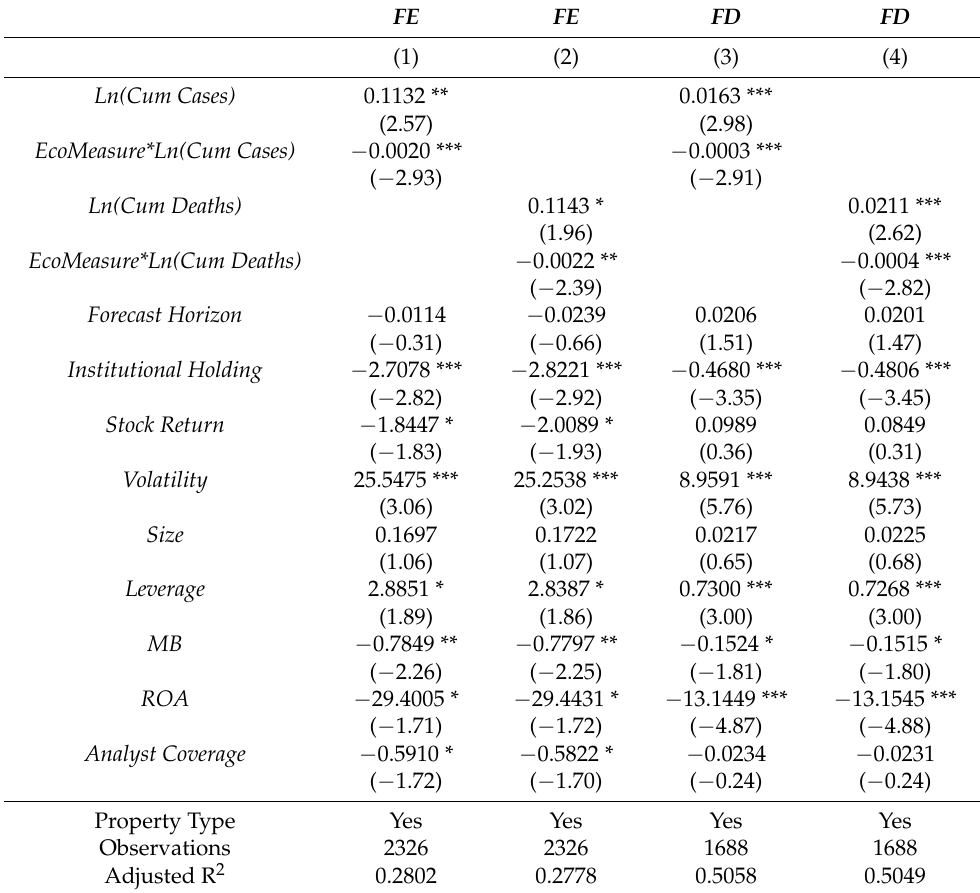
Table 7. Robustness Analysis—The Effects of Economic